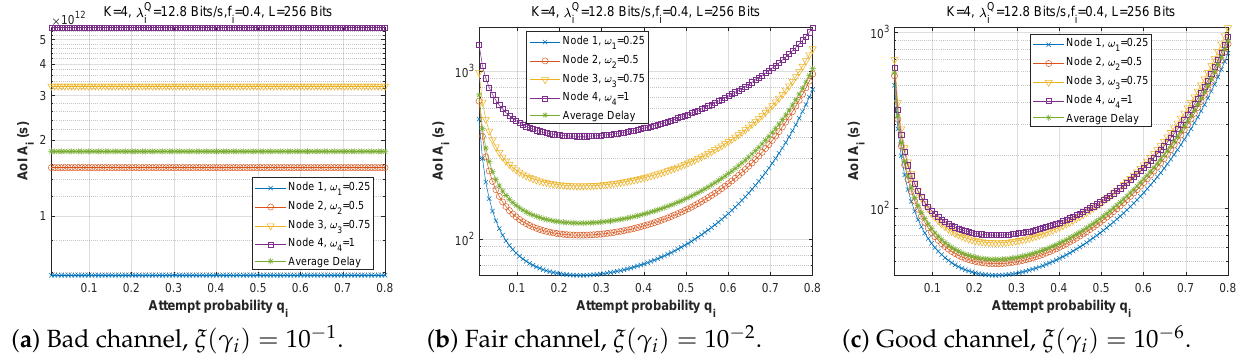
Figure 27. Scenario 3: The AoI experienced at each mobile device as a function of attempt probability for various bit error rates ξ ( γ i ) .